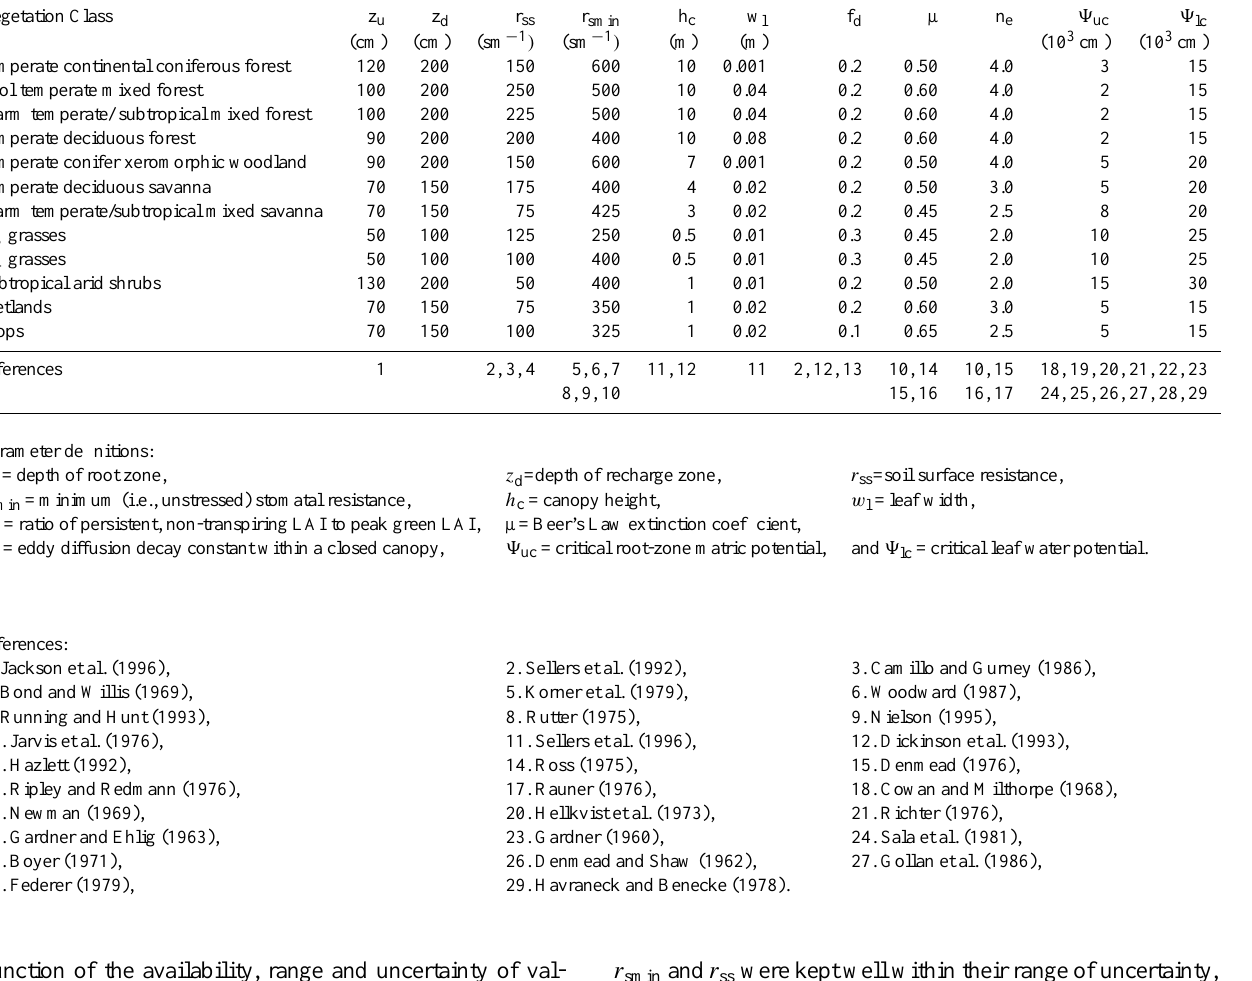
Parameter Values Specific to Vegetation